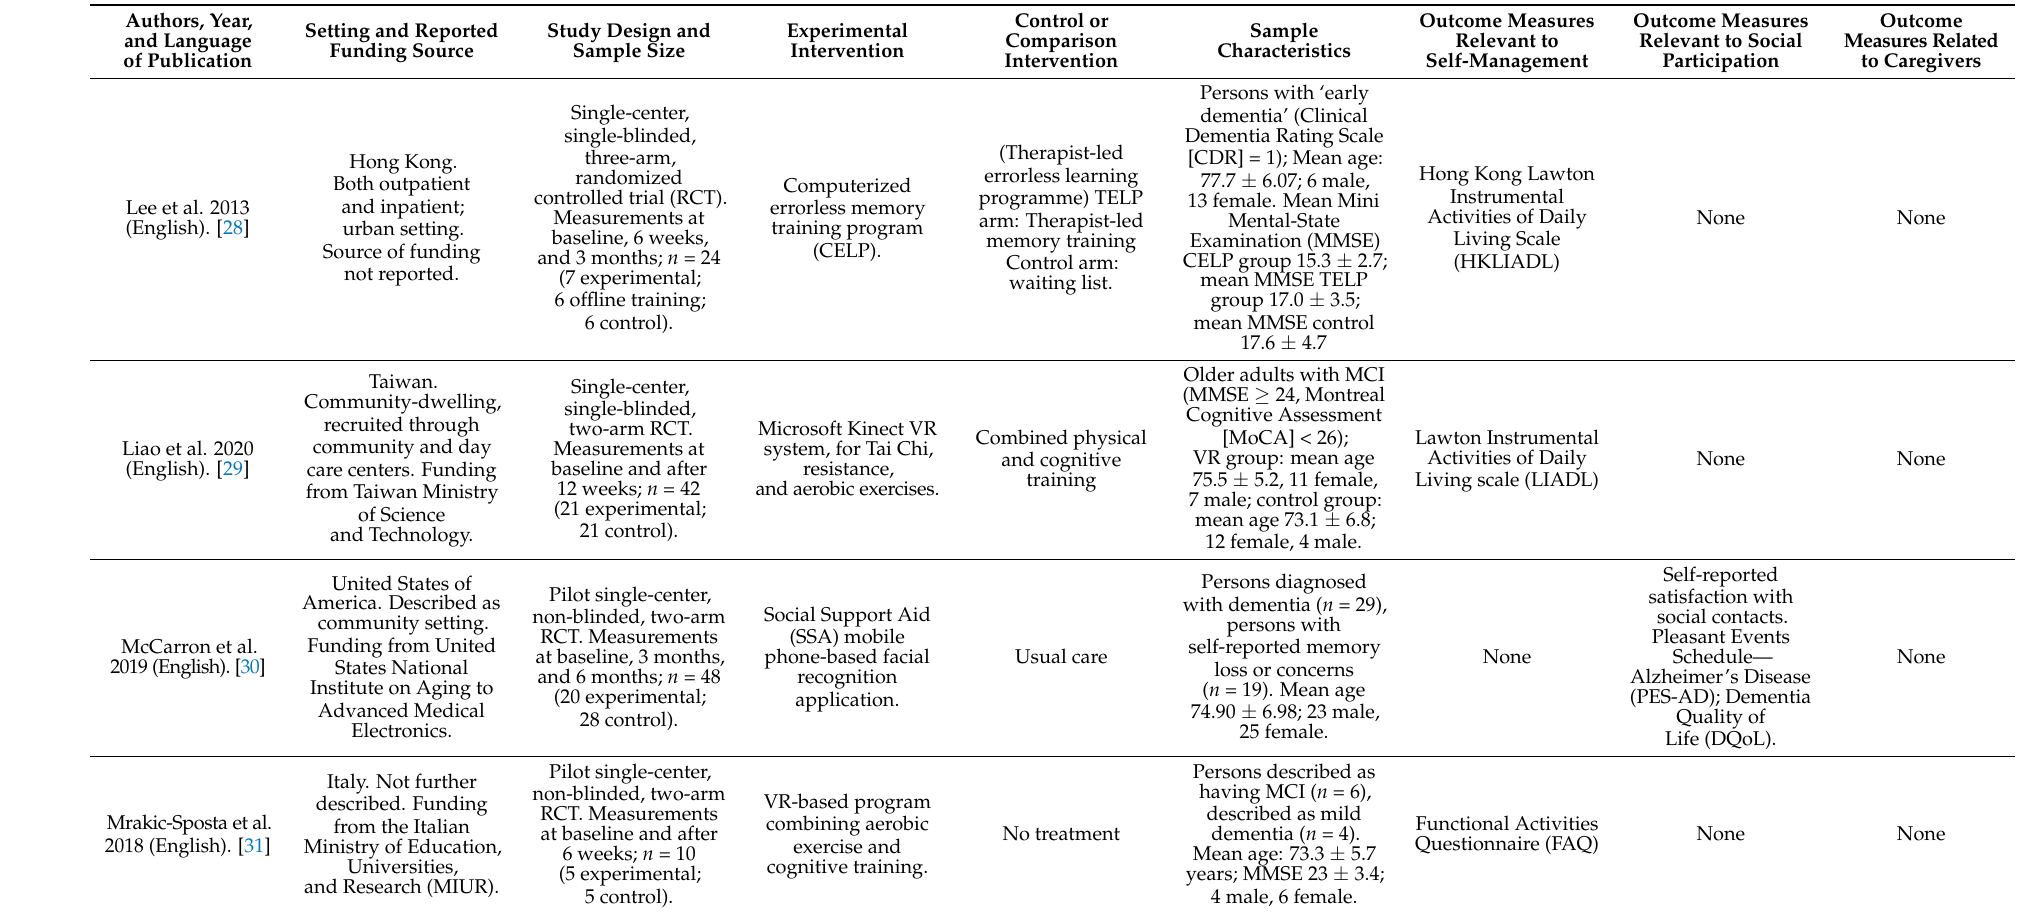
Table 1. Design and methods of included